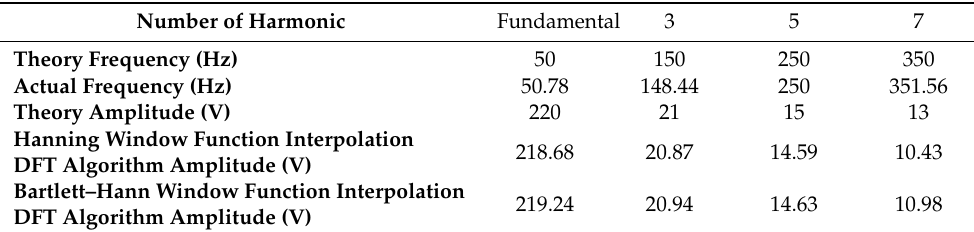
Table 3. Table of analysis results of steady-state harmonic components at low frequencies.